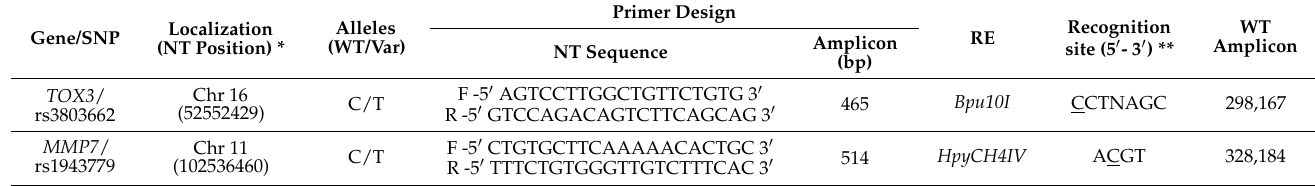
Table 1. SNP primers, genome localization, and restriction enzymes for RFLP assays.